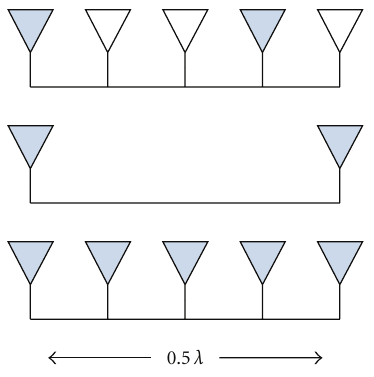
Figure 1: Configurations: (a) antenna selection (AS), (b) reduced full complexity (RFC), (c) full complexity